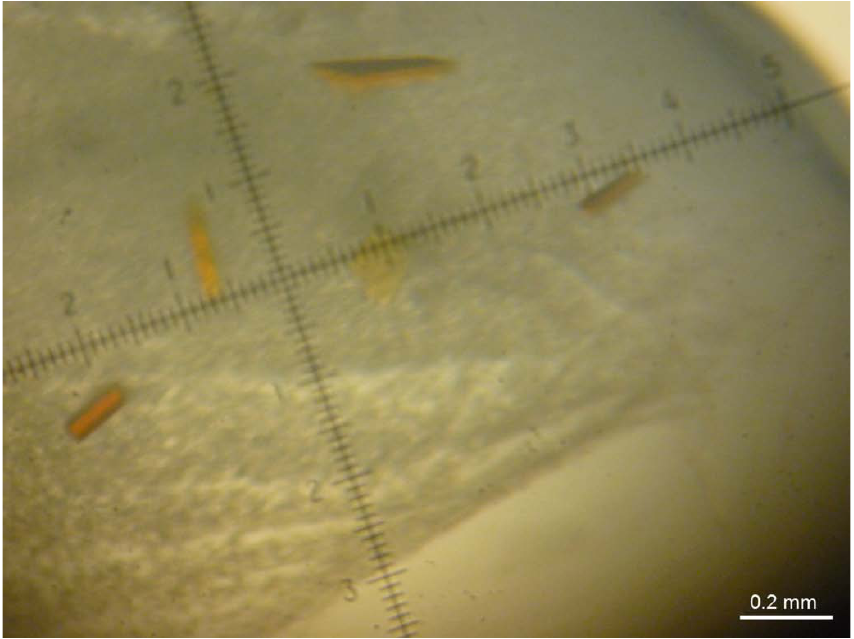
Figure 1. Crystals of PaoABC grow in 0.2 M ammonium iodide and 22% ( w / v ) polyethylene glycol 3350.